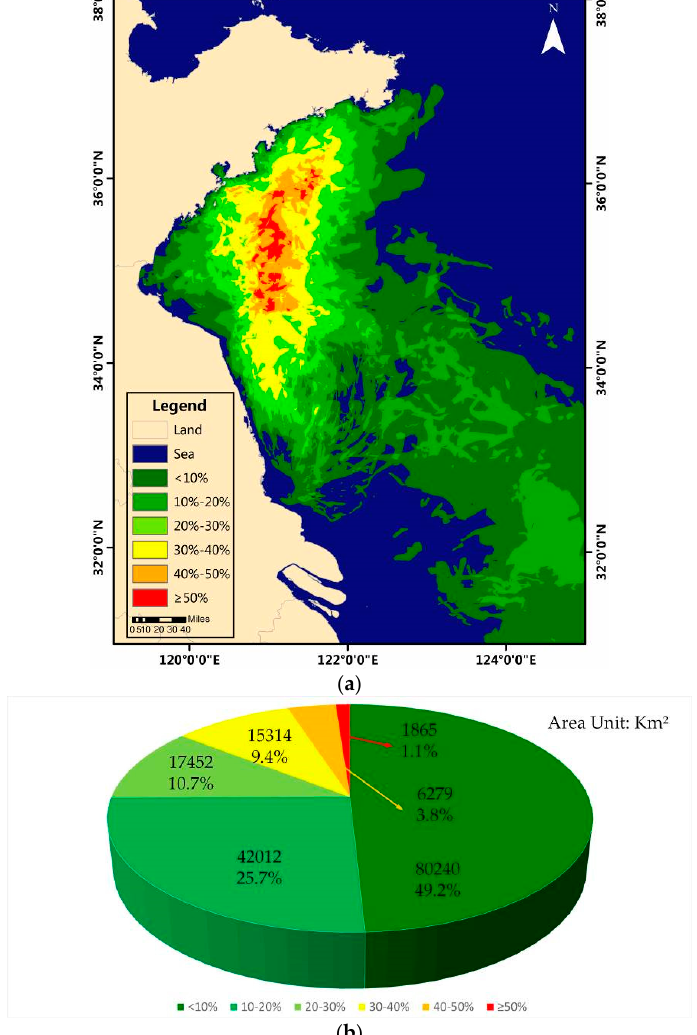
Figure 7. ( a ) The probability distribution of the occurrence of U. prolifera in the Yellow Sea during 2016–2018. From dark green to bright red, different colors represent different ranges of probability, with red ■ representing the highest-incidence area of U. prolifera . ( b ) The pie chart shows the percentage of the region corresponding to each probability as a part of the total affected area. The percentage and the specific area are shown on the pie chart. At the bottom of the pie chart, there is a probabilistic color bar. Each color corresponds to an interval of the probability of the occurrence of U. prolifera , the same as in ( a ).